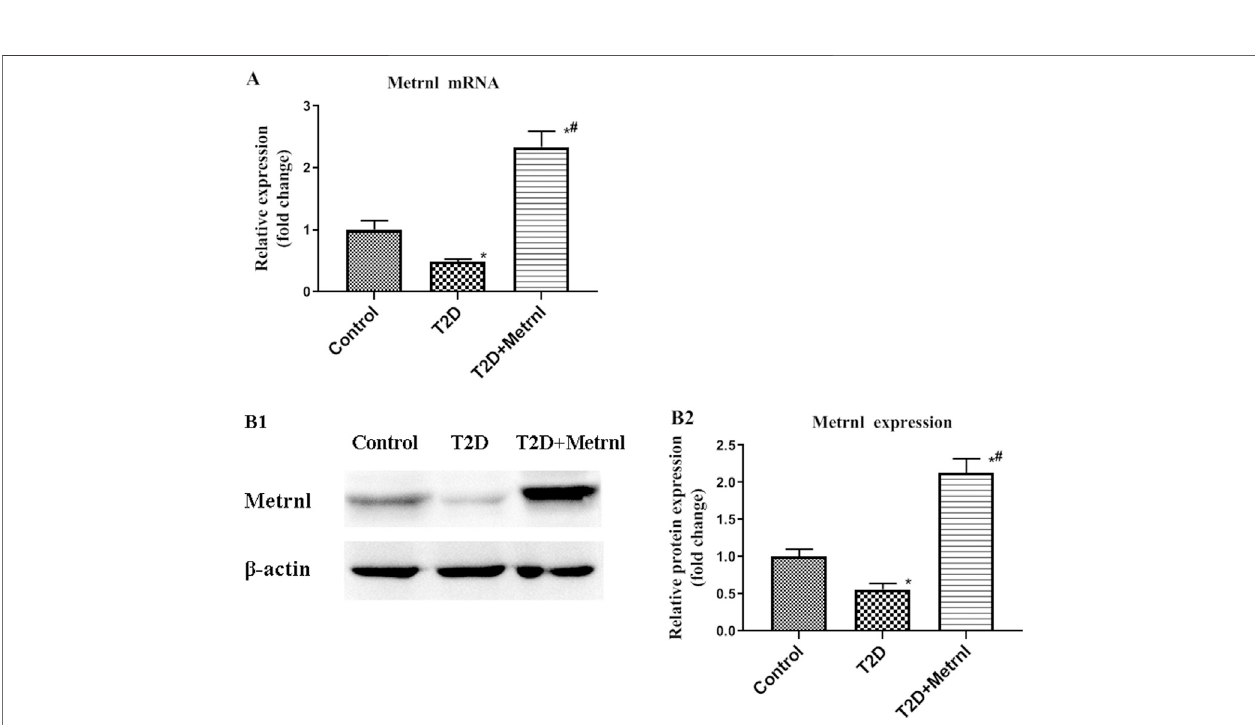
FIGURE 7 | The expression of Metrnl in pancreatic tissues of mice. (A) The gene expression of Metrnl quanti fi ed by real-time PCR. Data are presented as the fold change of transcripts for the target gene in the indicated groups normalized to β -actin. (B) Representative western blot showing Metrnl protein levels in MIN6 cells of different groups. Band densities were converted to a bar graph. All data are expressed as mean ± SEM [ n (cid:2) 8/group (mRNA), n (cid:2) 8/group (protein)]. * p < 0.05 for differences vs. control group; # p < 0.05 for differences vs. T2D group. T2D: type 2 diabetes.